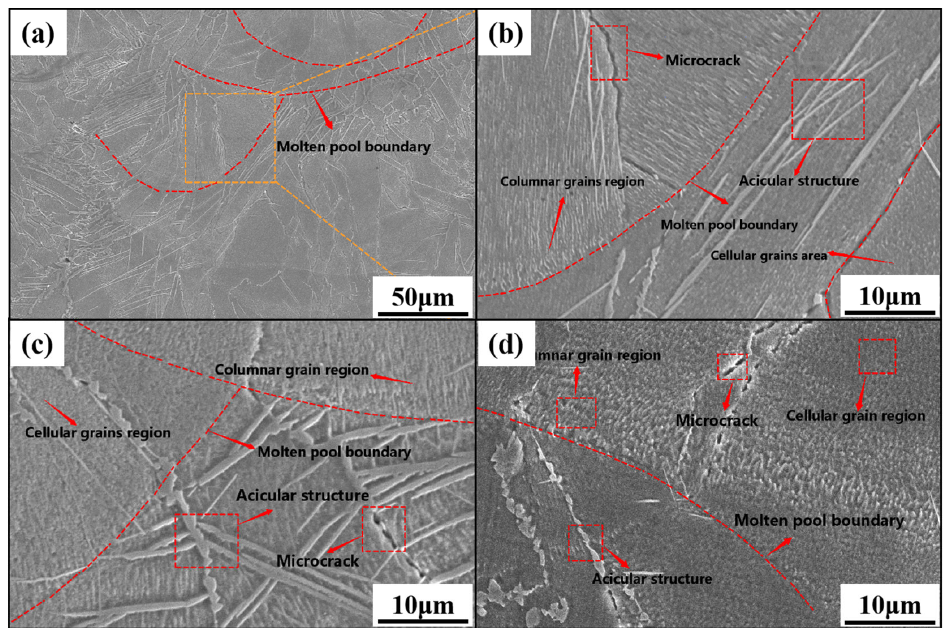
Figure 9. Microstructure of formed block at different scanning speeds:( a , b ) 1000 mm/s; ( c ) 500 mm/s; ( d ) 200 mm/s.